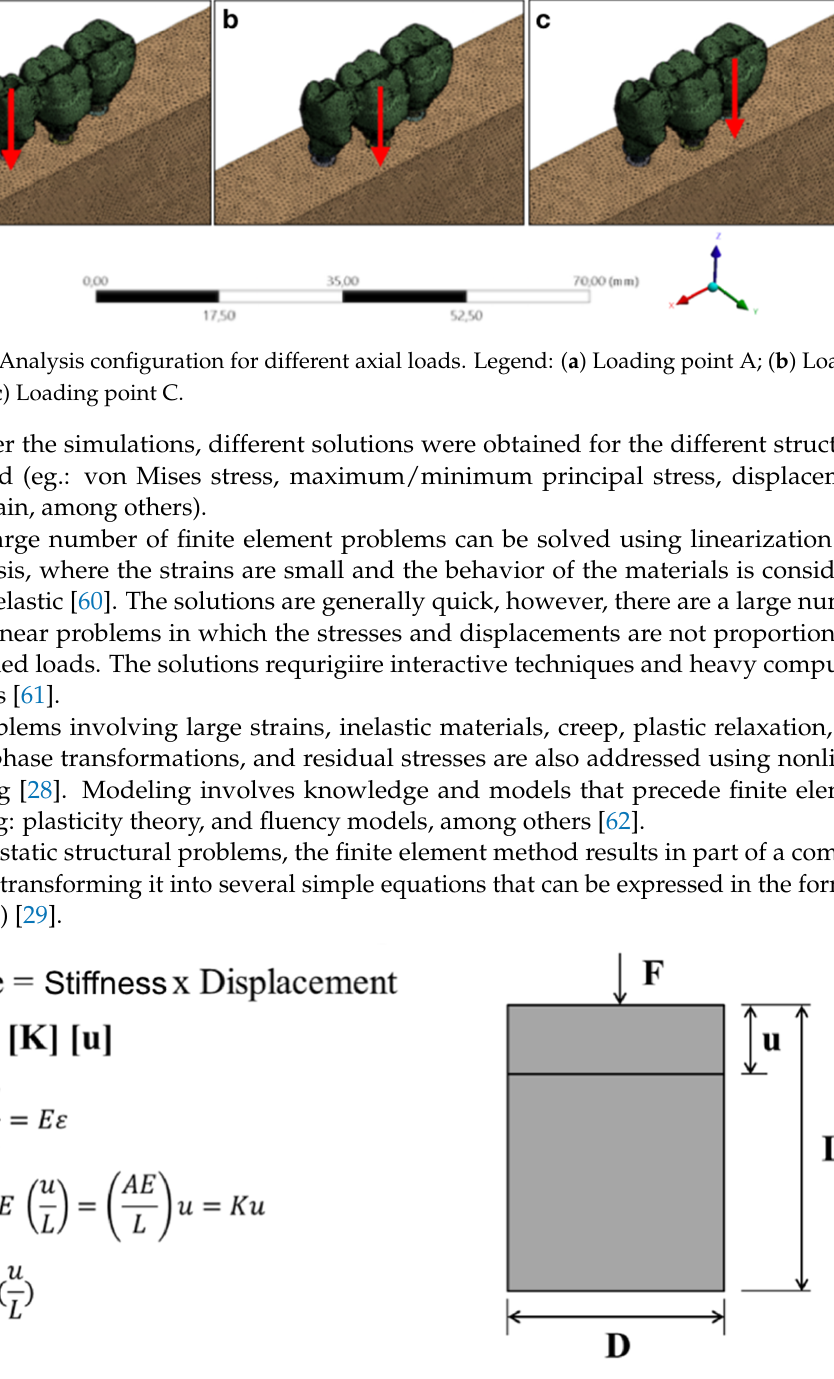
Figure 5. F: column of the force vectors, u: column of the displacement vectors, K: square matrix.